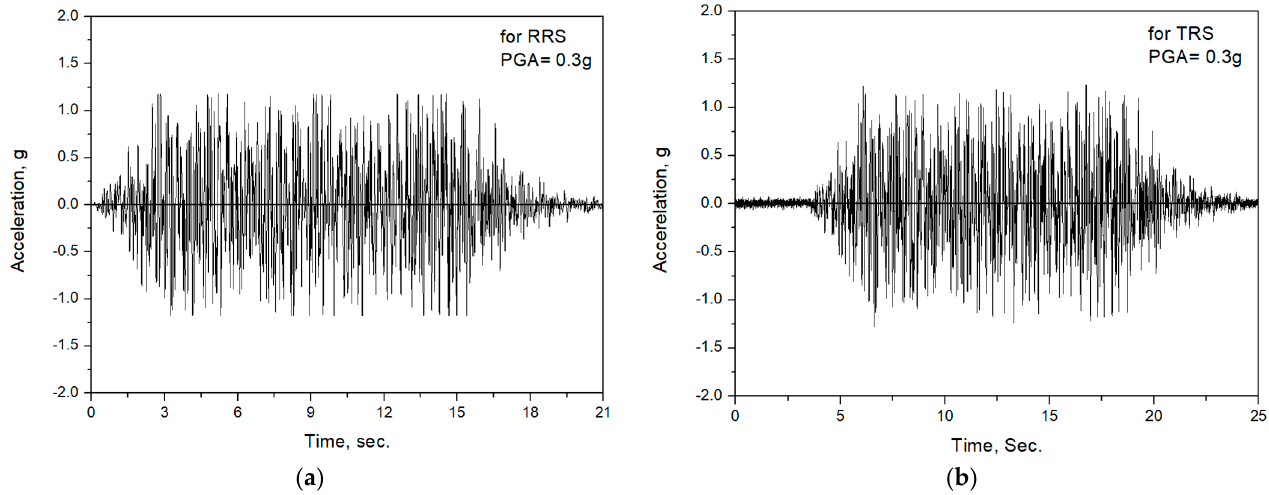
Figure 3. Acceleration time histories for shaking table input motion (PGA = 0.3 g): ( a ) Corresponding to RRS; ( b ) Corre- sponding to TRS.